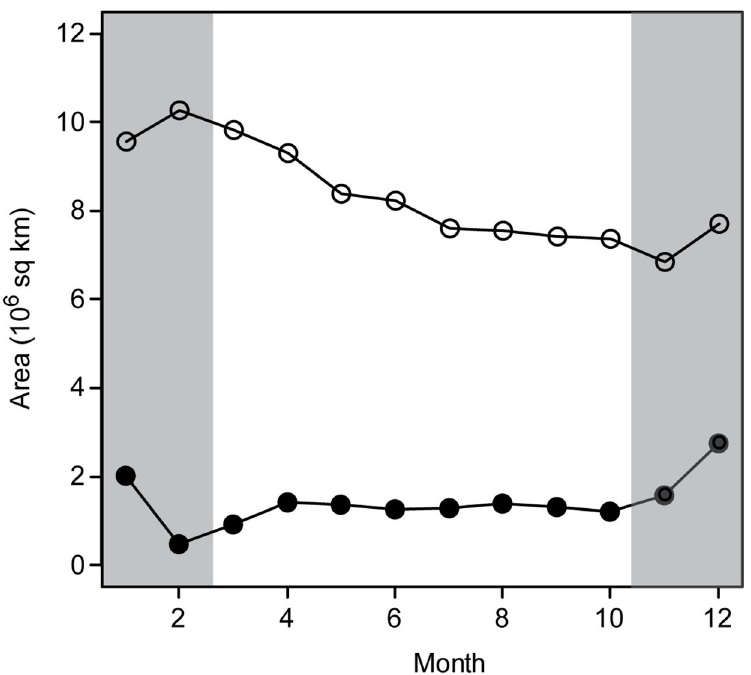
Fig 5. Area of open water and marginal ice zone habitats from 180˚ W to 0˚ W in 2017. Estimated areas of open- water habitat available (2˚C isotherm to 5% sea-ice concentration; open circles) and marginal ice zone (MIZ; 5–50% sea ice concentration; closed circles) habitat and to chinstrap penguins during 2017. The breeding season is marked in